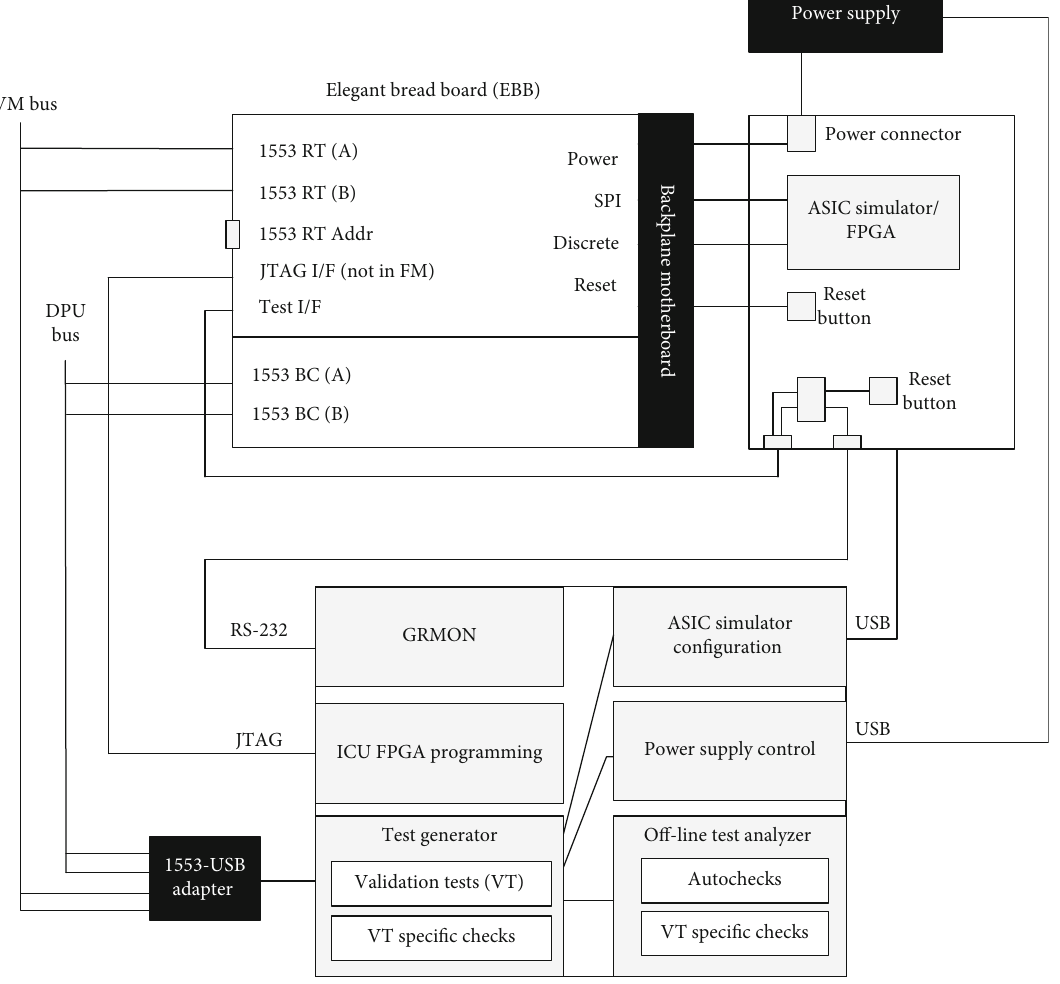
Figure 2: Test environment for BSW